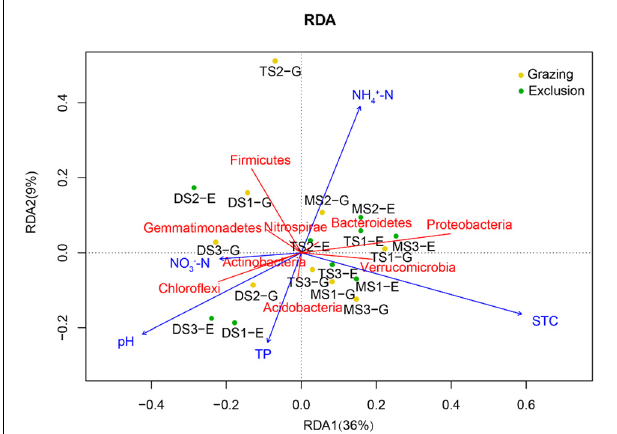
FIGURE 6 | Redundancy analysis of the significant soil chemical properties on the composition of bacterial community on phylum level. Blue arrows refer to soil chemical properties, red solid lines refer to bacterial phyla, and yellow and green dots refer to sampling